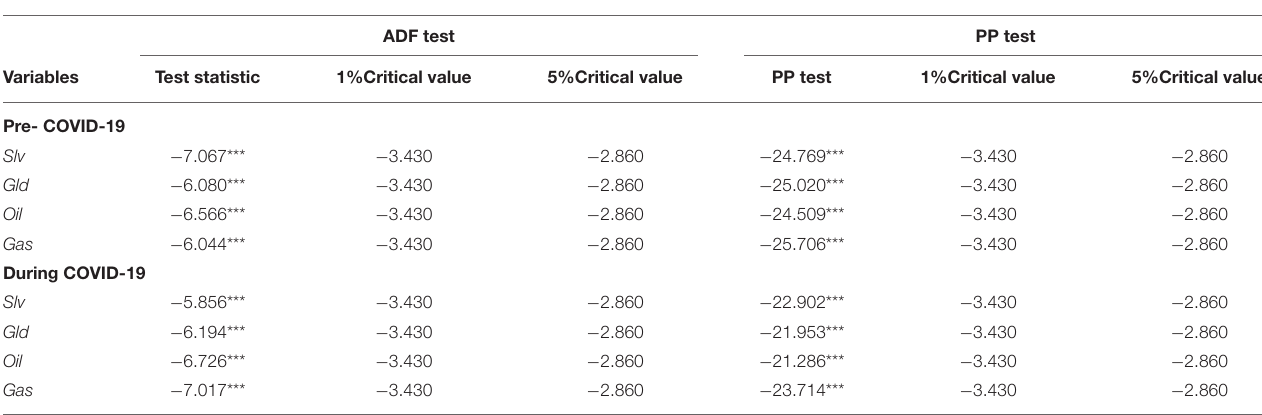
TABLE 3 | The results of unit root